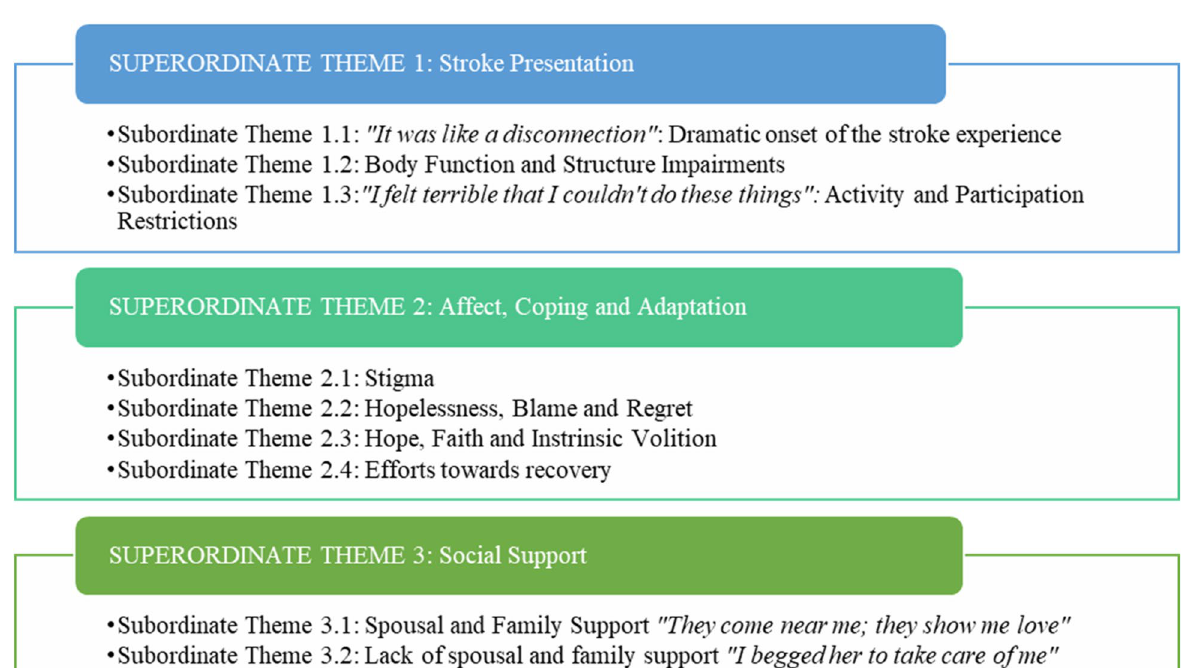
Fig. 1 Overview of superordinate and sub-ordinate